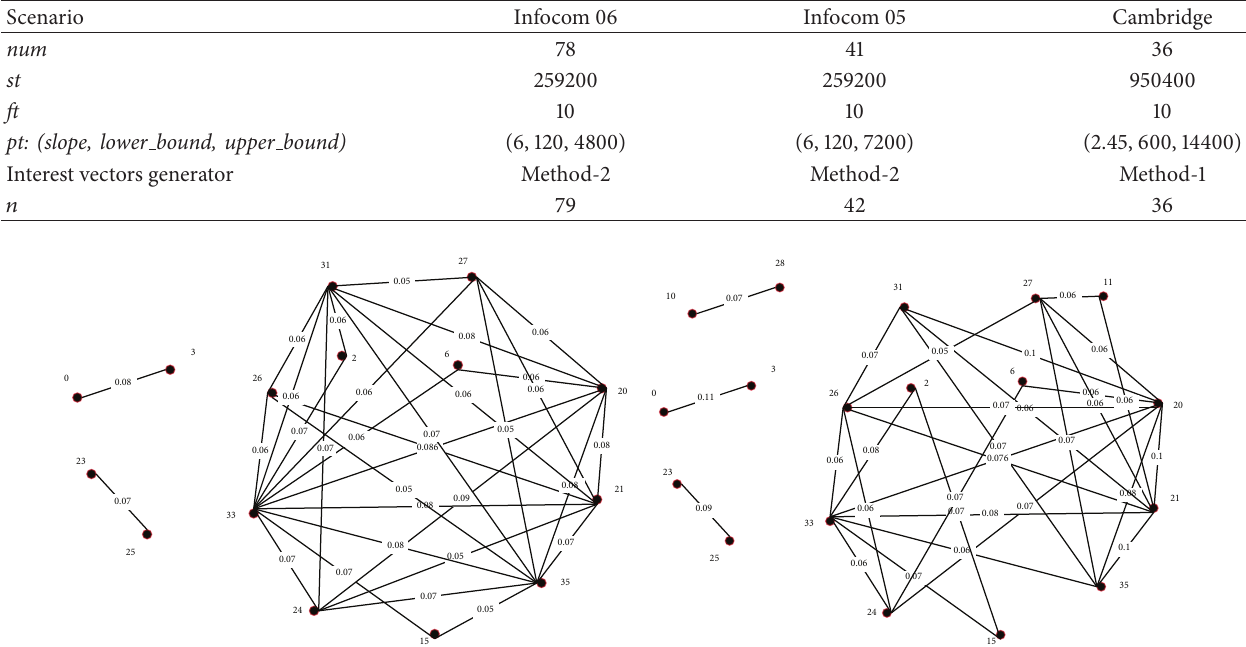
Table 3: Parameter settings.